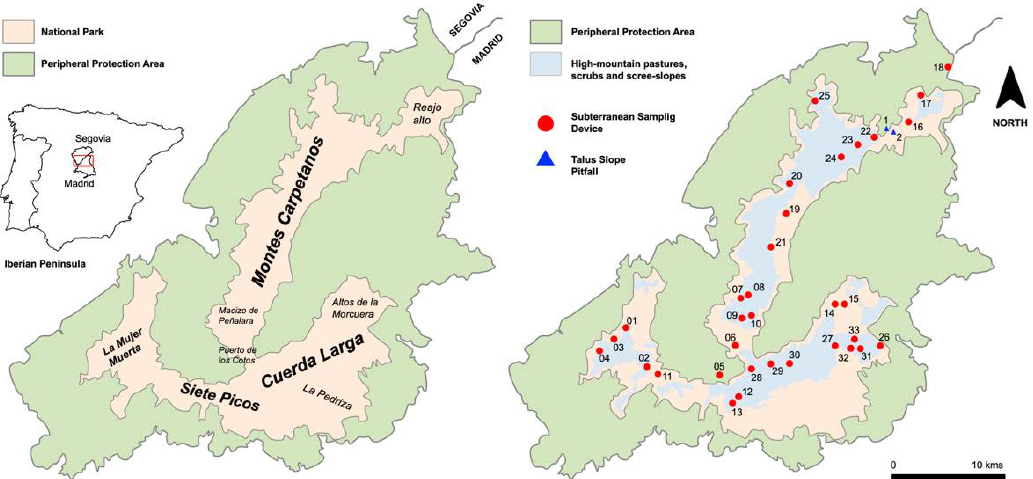
Figure 1. Maps of the Sierra de Guadarrama National Park. Basic orography ( left) , and habitats that occupy greater surfaces ( right) . The spatial location of the sampling points is indicated and numbered.